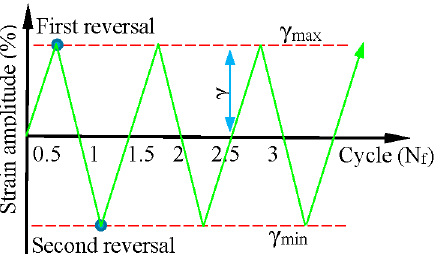
Figure 2. Loading pattern. Table 2. Details of the cyclical shear test specimens.